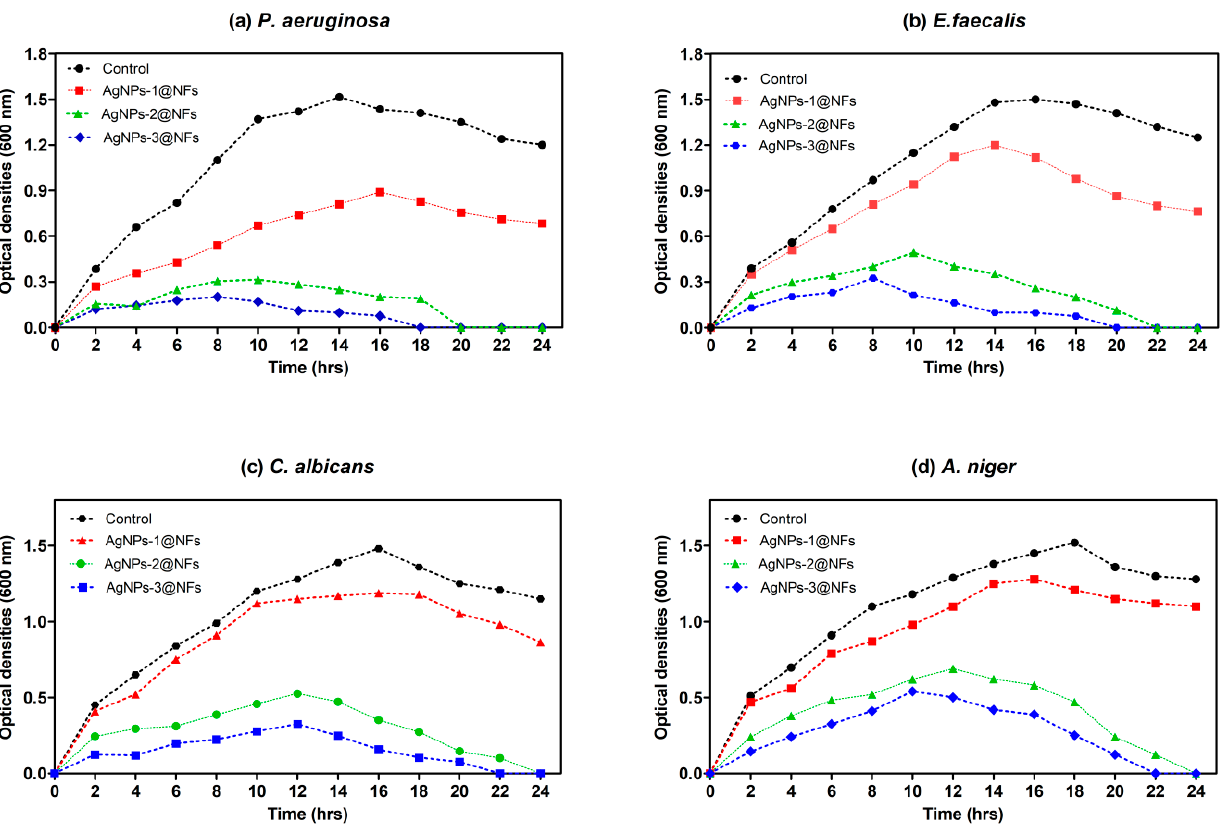
Figure 12. The curves of growth for ( a ) P. aeruginosa , ( b ) E. faecalis , ( c ) C. albicans , ( d ) A. niger treated with three nanofibers (AgNPs-1@NFs, AgNPs-2@NFs, and AgNPs-3@NFs) within 2–24 h. The obtained values epitomize the mean ± SD of triplicate trails.